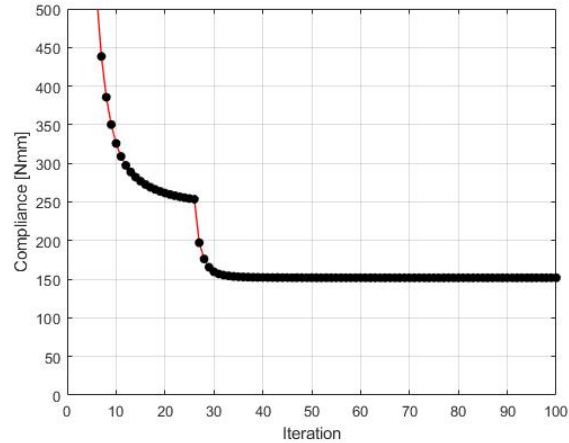
Figure 11. The compliance history for the test structure 1. Minimal value: 151.84 Nmm. Black dots on the red line represent the compliance values for subsequent iterations.